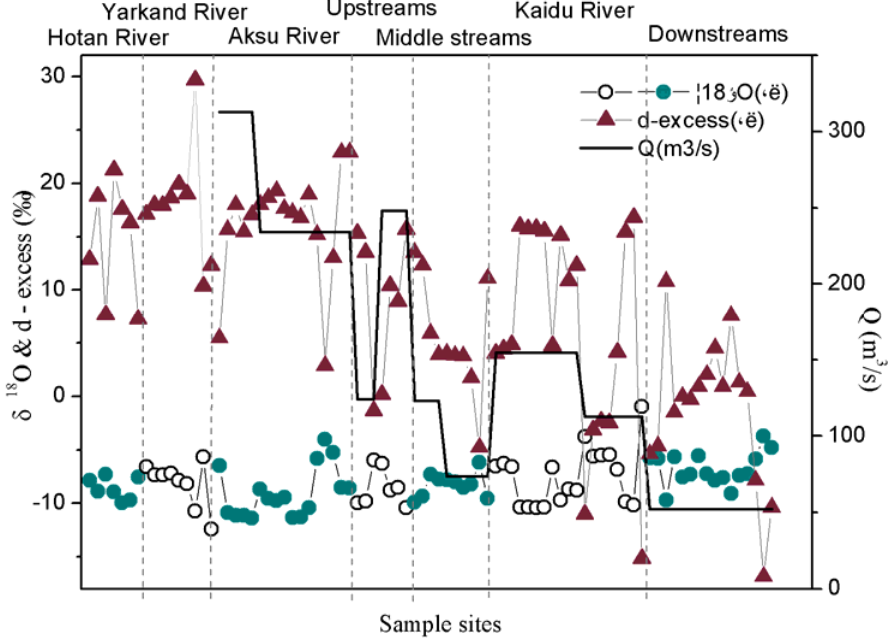
Figure 6. Time series of discharge (solid line, m 3 /s) in the whole Tarim River at the hydrological stations, and fluctuations of δ 18 O (circles, ‰) and d ‐ excess (triangles, ‰) sampled from the deep river water (at least 30 cm below the surface of the water) near the wells.